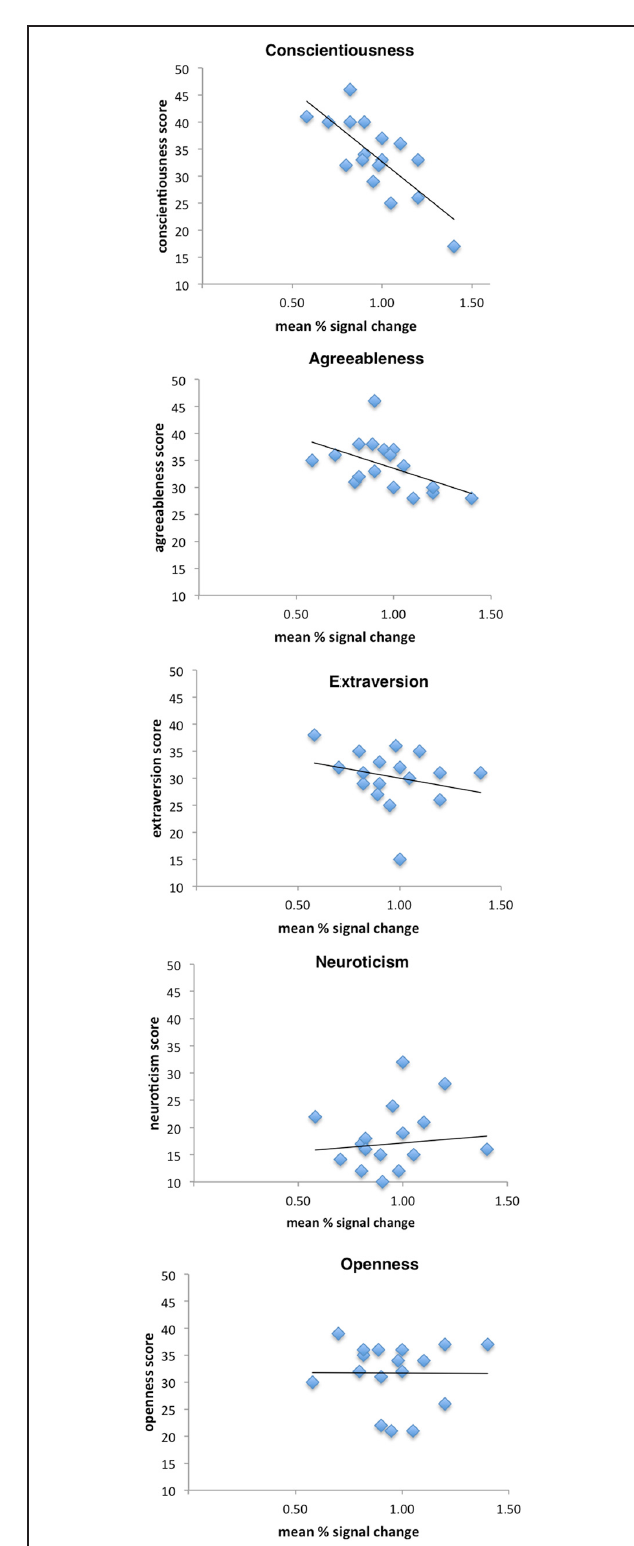
FIGURE 3 | Correlation scatterplots for personality dimensions and left mid insula activation when observing a touched hand. Results demonstrated a significant negative correlation with the personality dimension conscientiousness (see text for further